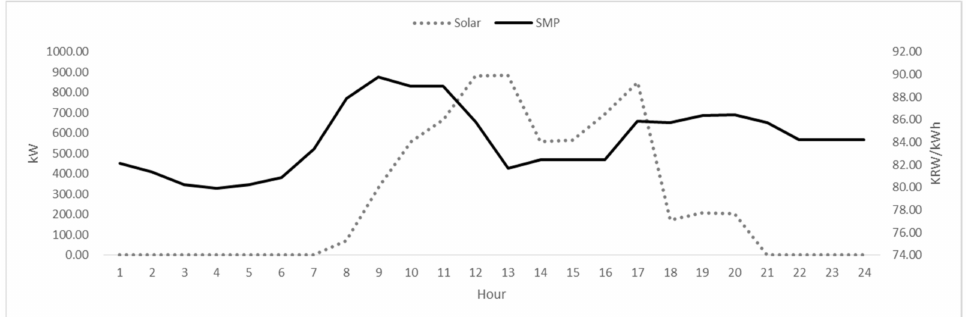
Figure 9. Solar power metered with hourly granularity and Pattern of the SMP on 11 March 2020.